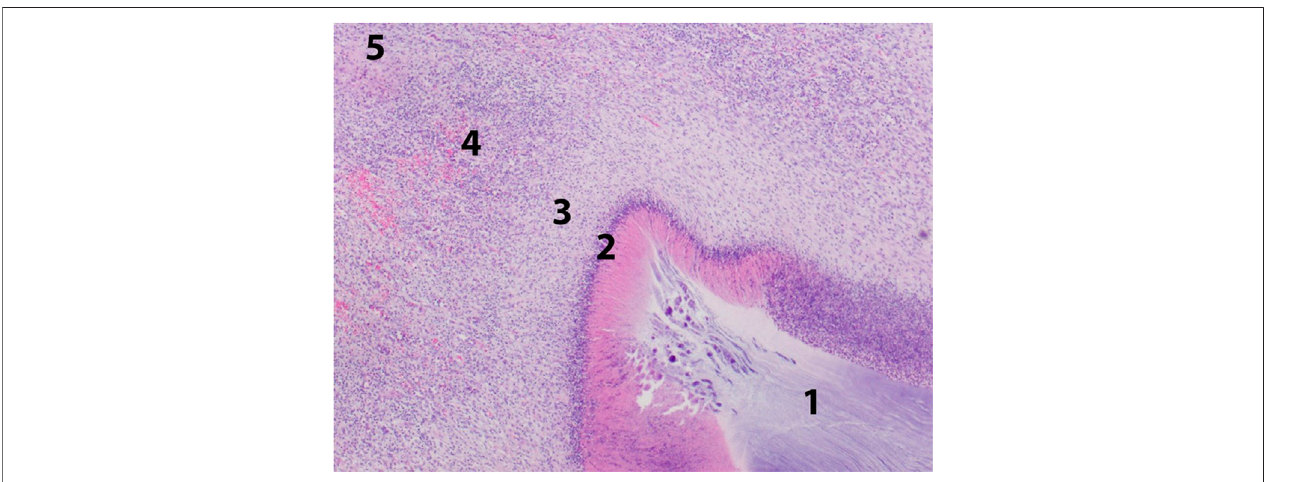
FIGURE 1 | Body integument - resorptive reaction to an implant. Zone 1: implant, zone 2: purulent necrosis, zone 3: macrophagal in fi ltration, zone 4: granulation tissue, zone 5: fi brous scar tissue.